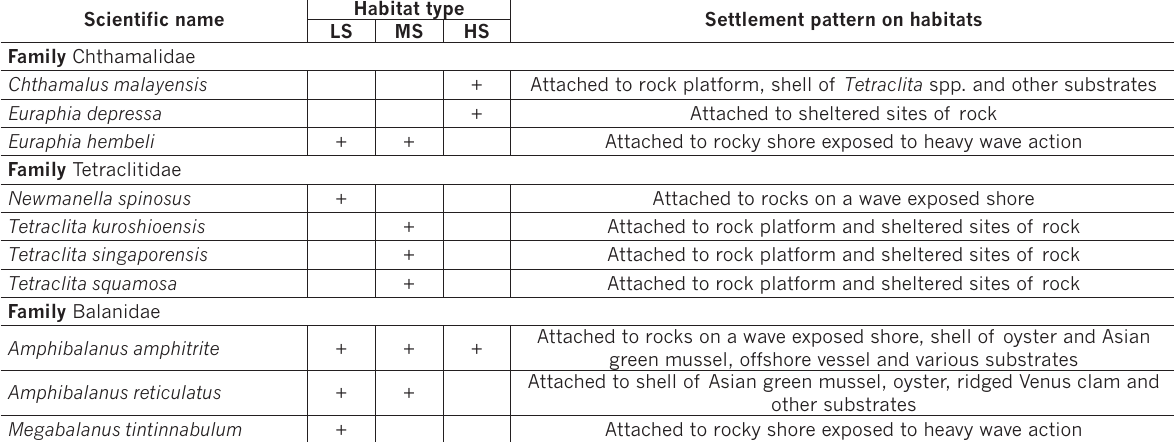
Table 3. Distribution of acorn barnacles on different habitat types of intertidal zone (vertical zonation): low shores/ sublittoral zone (LS), middle Shores/ littoral zone (MS), and high shores/ supralittoral zone